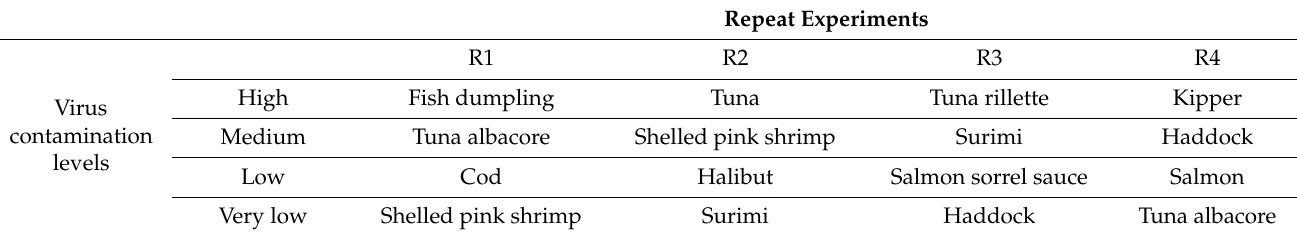
Table 2. Experimental design for detection of enteric viruses (HAV, HEV, and noroviruses) in fish products adapted from the ISO 16140-4